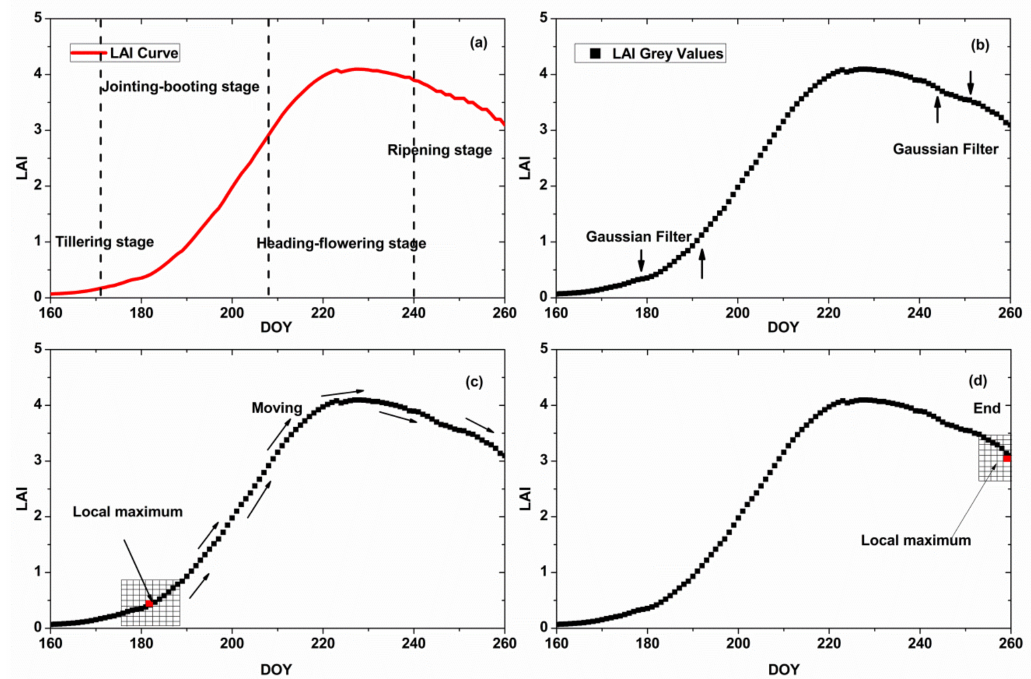
Figure 4. Harris algorithm process for the LAI curve. ( a ) is the original LAI curve; ( b ) is the smoothed LAI curve, the filter is Gaussian filter; ( c , d ) are the process of the Harris point detection.